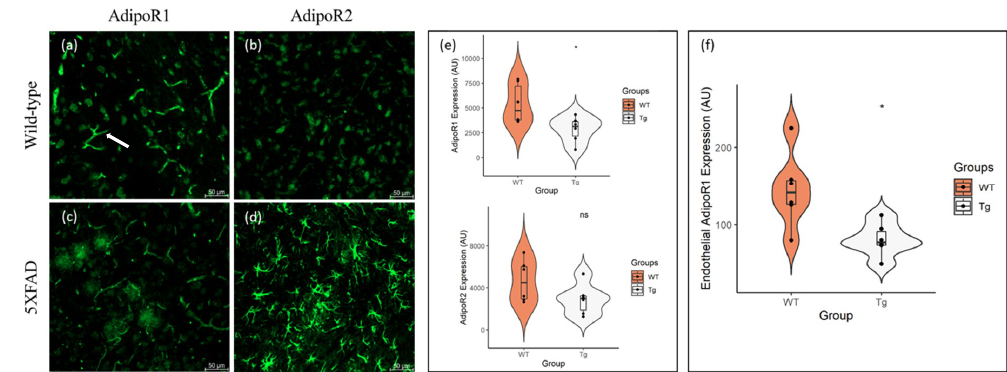
Figure 1. Expression of AdipoR1 and AdipoR2 in the cortices of 48–52-week-old 5XFAD and wild-type (WT) mice. AdipoR1 is present in neurons of both ( a ) WT and ( c ) 5XFAD mice, in addition to endothelial cells lining blood vessels (arrow). Both ( b ) WT and ( d ) 5XFAD mice also express AdipoR2 in neurons, with substantial glial expression of AdipoR2 in ( d ) 5XFAD mice. There was a reduction in ( e ) neuronal AdipoR1 and AdipoR2 expression in the 5XFAD (Tg) cortex, compared to controls, with statistical significance observed in AdipoR1 expression. Endothelial expression ( f ) of AdipoR1 was also significantly reduced in the 5XFAD (Tg) cortex. Data are presented as Mean ± SEM using independent t-test with statistical significance * p < 0.05 denoted between groups. Images were taken at 20 × magnification. Scale bar = 50 µ